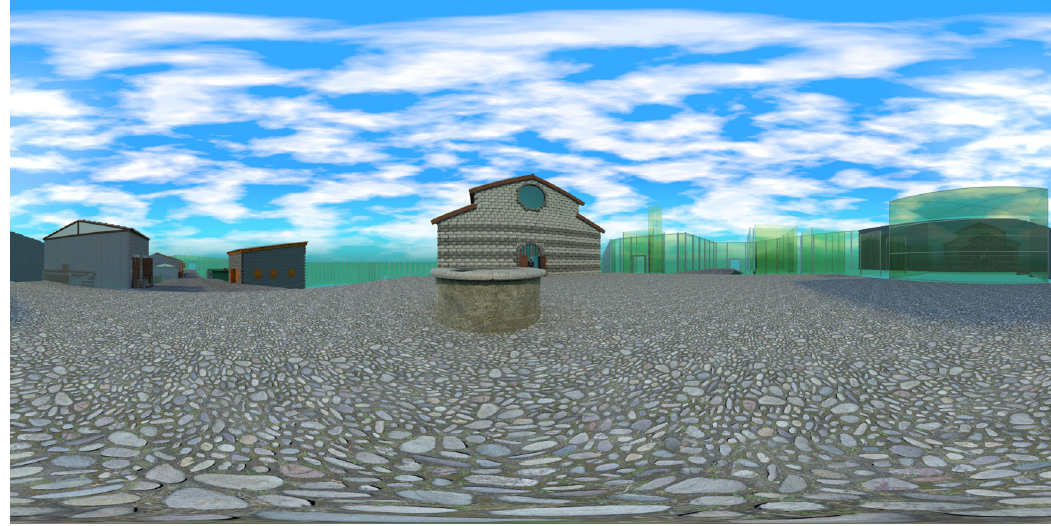
Figure 10: 360° render of Podium Bonizi